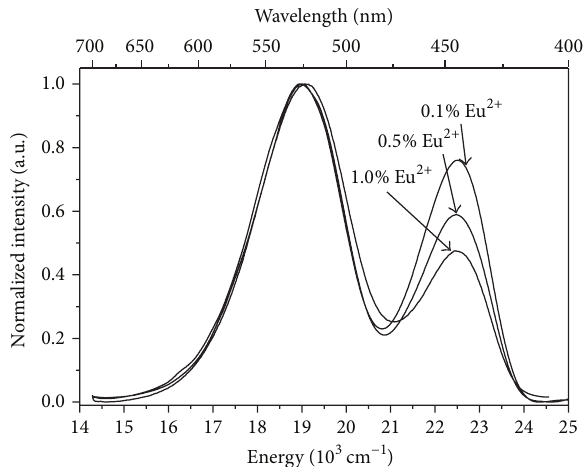
= 27 620 cm −1 ) of 2 (0.1% Eu 2+ ), 3 ex